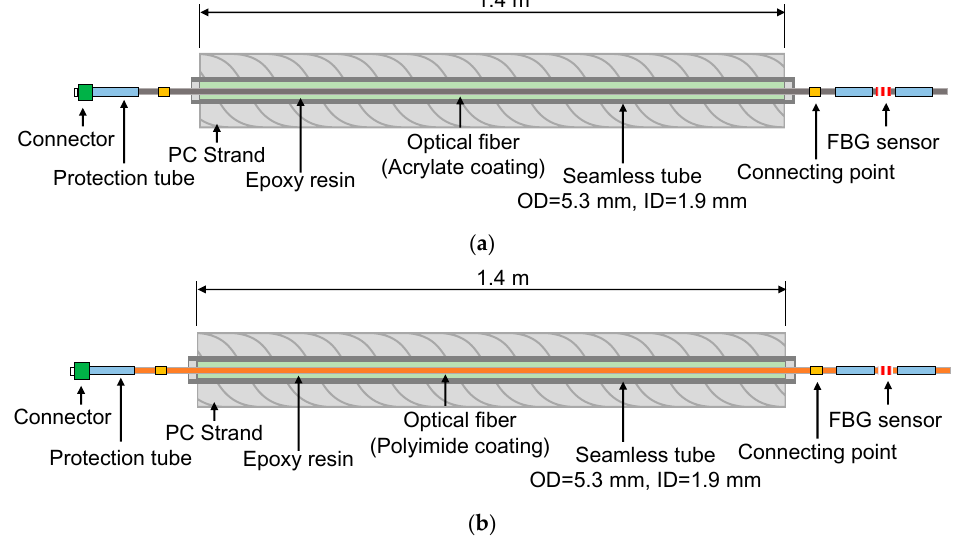
Figure 6. Schematic diagram of strand-embedded optical fibers recoated with two types of materials: ( a ) OF-A (recoated with acrylate); ( b ) OF-P (recoated with polyimide).